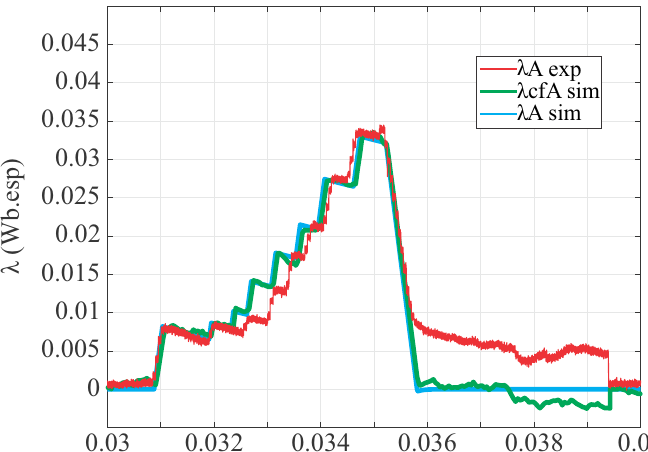
Figure 14. Comparison between experimental and simulation results.